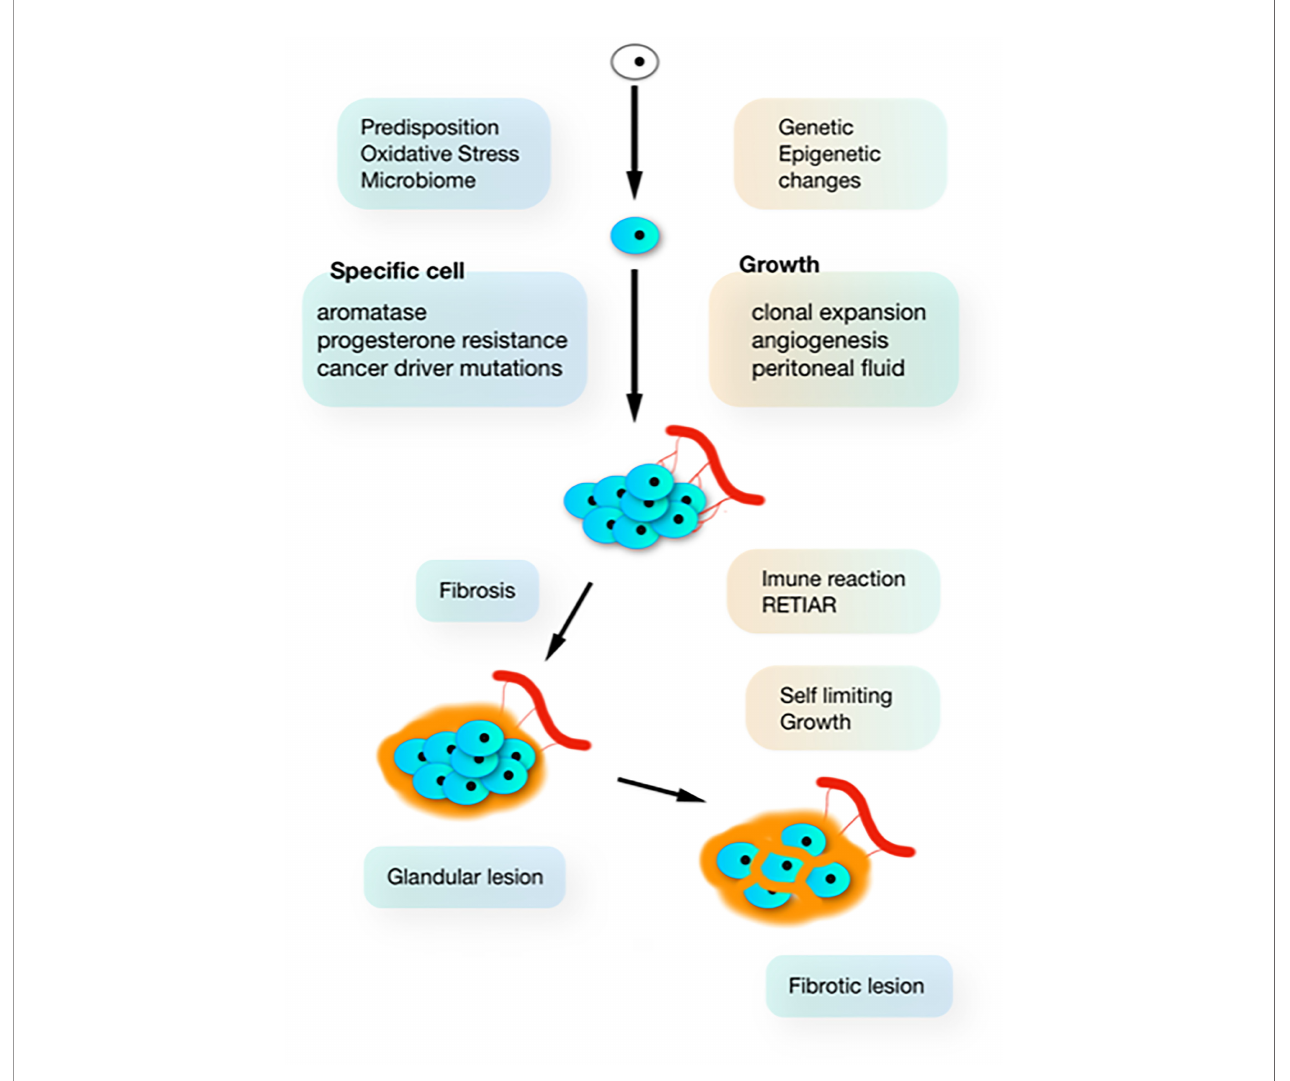
FIGURE 1 | The natural history of endometriosis. In susceptible women, additional G-E incidents (driven by oxidative stress from retrograde menstruation and infection) induce clonal and heterogenous hetrogeneous (aromatase and progesterone resistance) lesions, which develop in the peritoneal cavity which is a speci fi c microenvironment. Inhibition of growth by progressive fi brosis (because of immunology and bleeding in the lesions) results in variable severity of